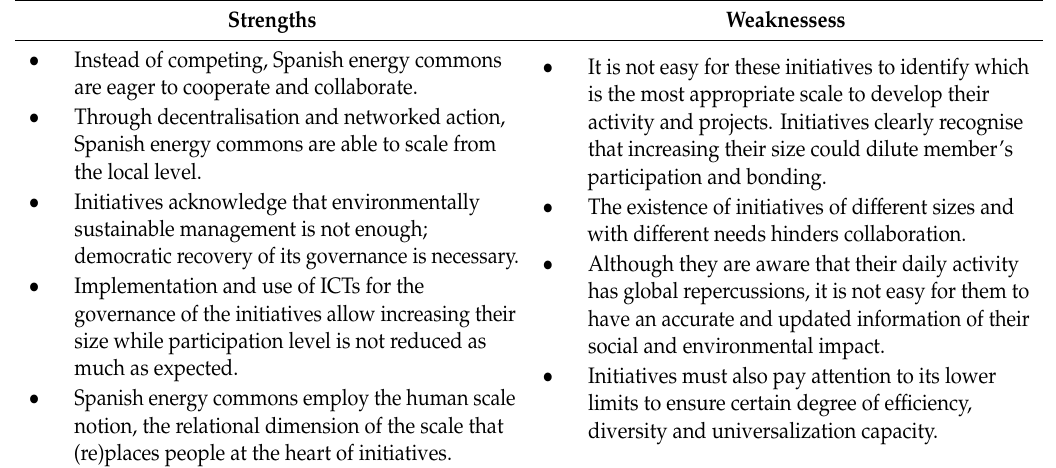
Table 2. Summary of scalability strengths and